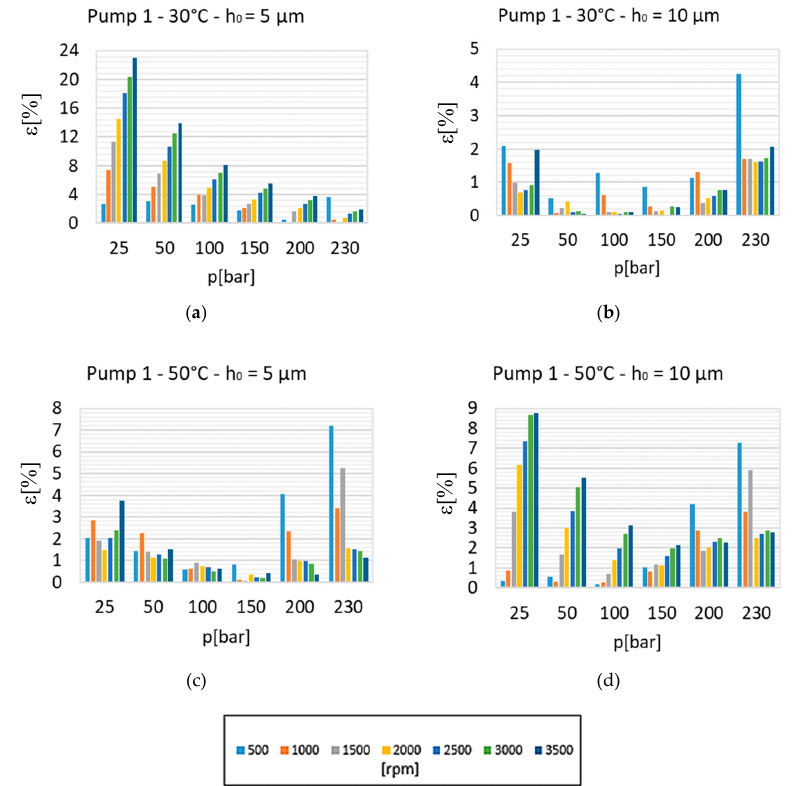
Figure 8. Relative errors on the calculation of the mechanical efficiency of pump 1 for different operating conditions and fluid temperature: (a) 30°C and h 0 =5 μ m ; (b) 30°C and h 0 =10 μ m; (c) 50°C and h 0 =5 μ m; (d) 50°C and h 0 =10 μ m